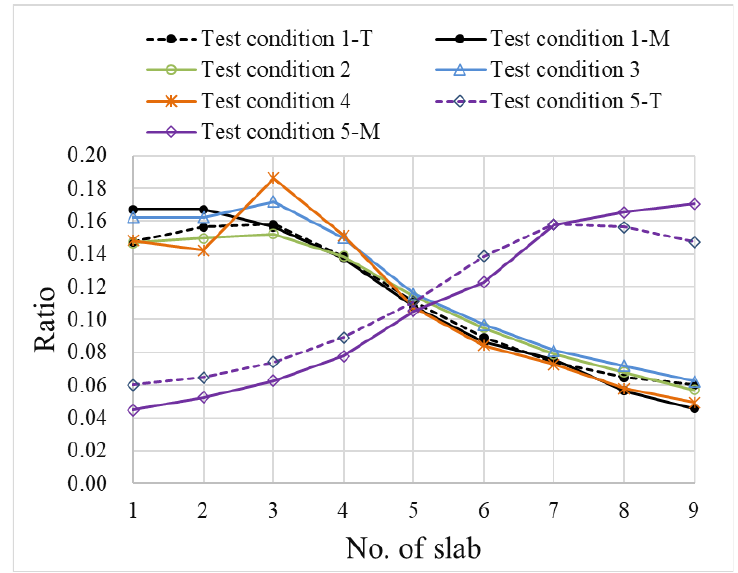
Figure 9. Load distribution ratio of different test conditions.